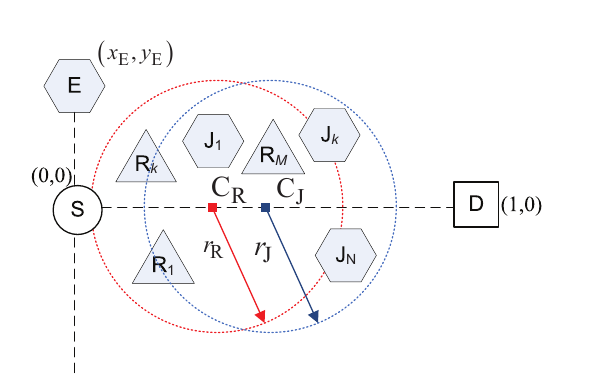
Figure 2. Locations of nodes in the system